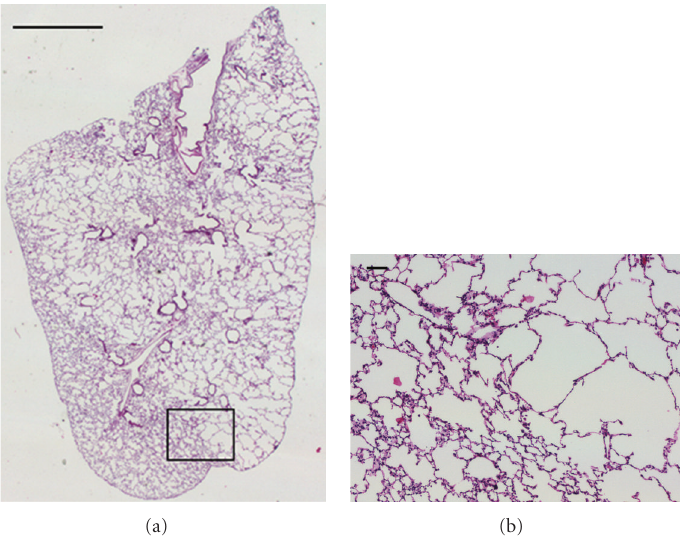
Figure 3: Sample histology images corresponding to a lung lobe slice of a mouse 17 days after instillation. (a) Mosaic acquired at 1.25x magnification. Scale bar represents 1000 microns length. (b) Zoomed area acquired at 10x. Scale bar represents 100 microns length. The mosaic (a) shows heterogeneous distribution of airspace enlargement. In the zoomed area (b), the left portion corresponds to normal alveolar tissue and the right shows the typical airspace enlargement found in emphysema.